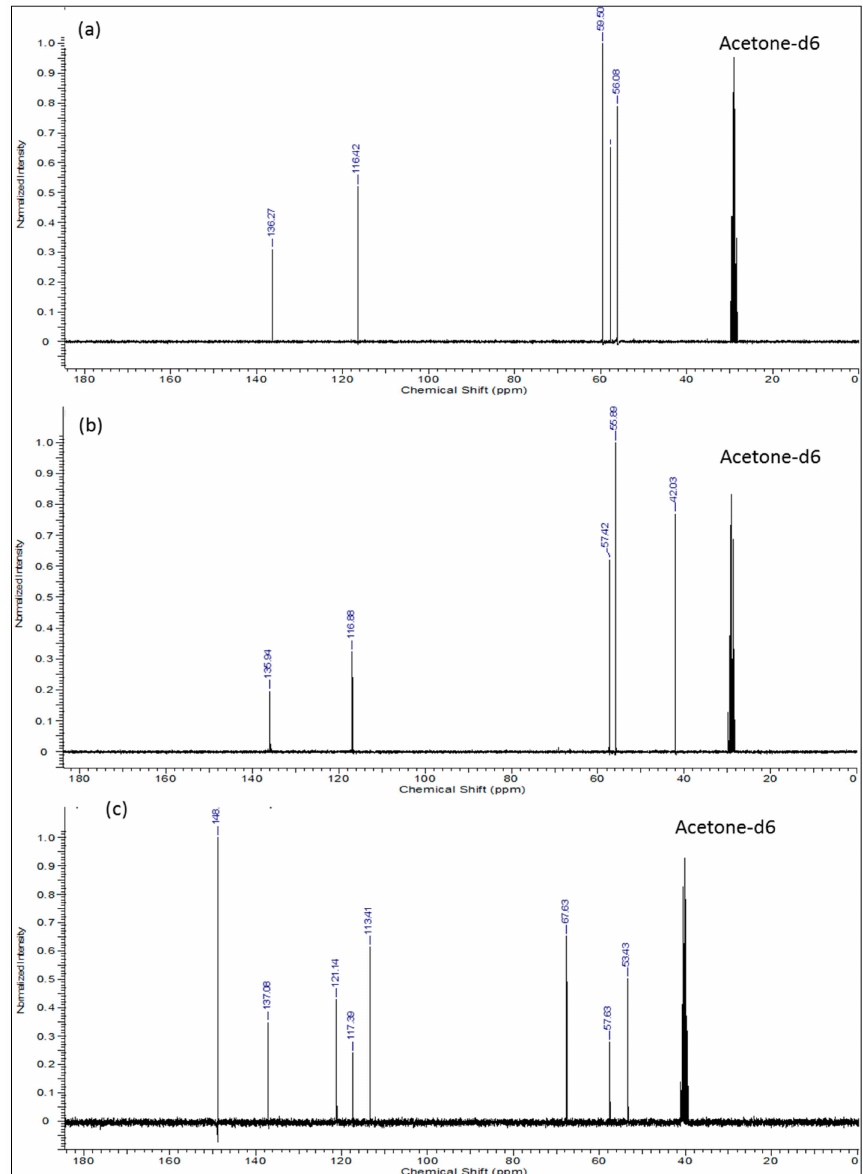
Figure 3. 13 C-NMR spectra of: ( a ) 2,2 1 -(prop-2-en-1-ylimino)diethanol ( 2 ); ( b ) N,N -bis(2-chloroethyl) prop-2-en-1-amine ( 3 ) and ( c ) N,N 1 -diallyl-7,16-diaza-1,4,10,13-tetraoxa-dibenzo-18-crown-6 ( 4